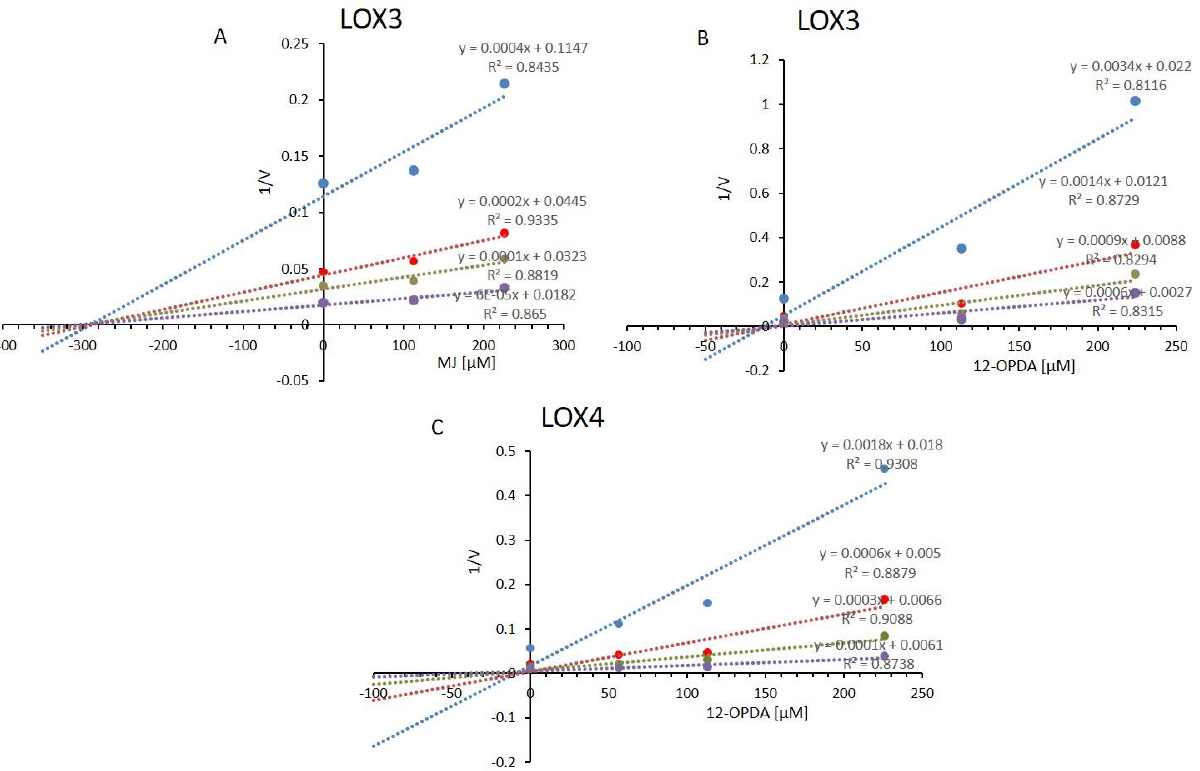
Figure 6. Dixon plots for the inhibition of LOX3 by MJ ( A ) and 12-OPDA ( B ) and LOX4 by 12-OPDA ( C ) Blue symbols and fitted straight lines represent enzyme activity with 1.6 µM substrate, while red, green and violet represent enzyme activities with 4.8 µM, 12.8 µM and 25.6 µM LeA. As for LOX4, blue symbols and fitted straight lines represent enzyme activity with 1.6 µM substrate, while the red, green and violet represent enzyme activities with 9.6 µM, 16 µM and 32 µM LeA. Analysis of pre-incubated protein (0.22 mg/mL), at 30 °C (control, solvent of 12-OPDA or MJ), was performed as described in Section 4.6. Values were obtained from the data presented in Figures S9 and S10.